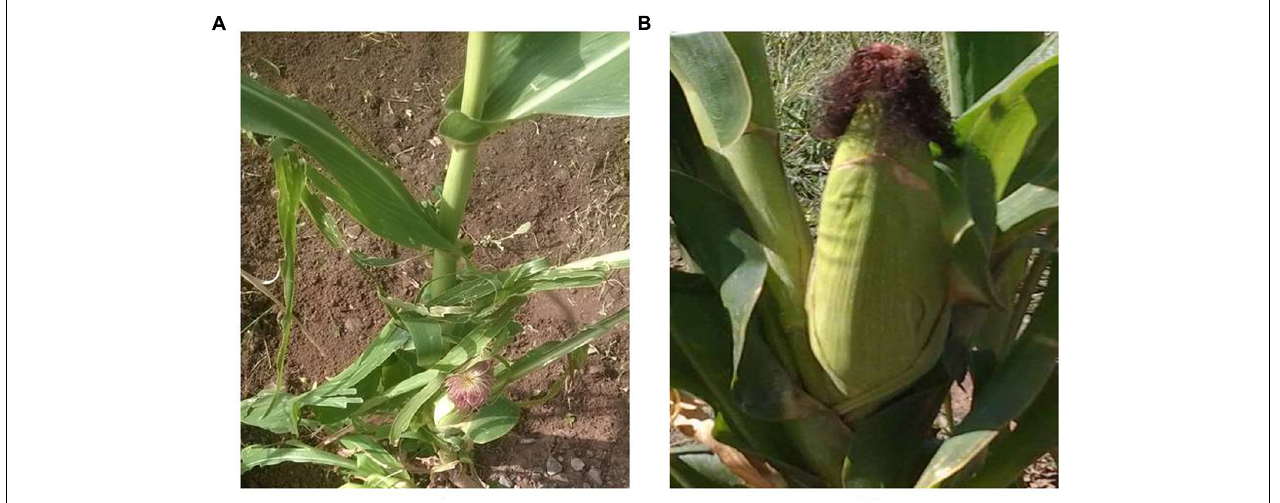
FIGURE 1 | Biofertilizer effect of Pseudomonas sp. on maize. (A) Maize not inoculated with a PSM. (B) Maize inoculated with a PSM Pseudomonas sp.